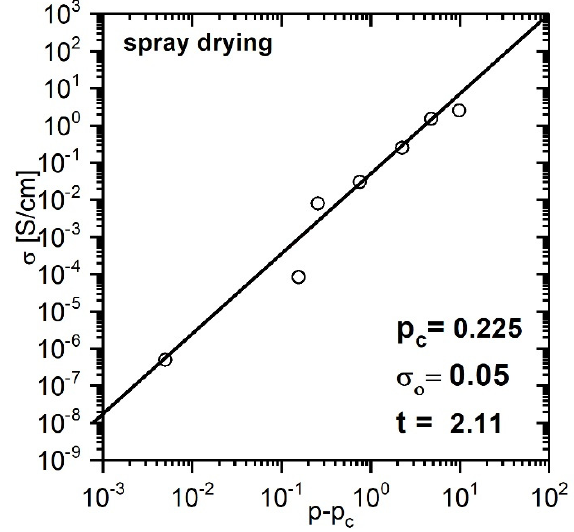
Figure 8. PLA/CNT nanocomposites specific conductivity in constant electric field vs p − p c.